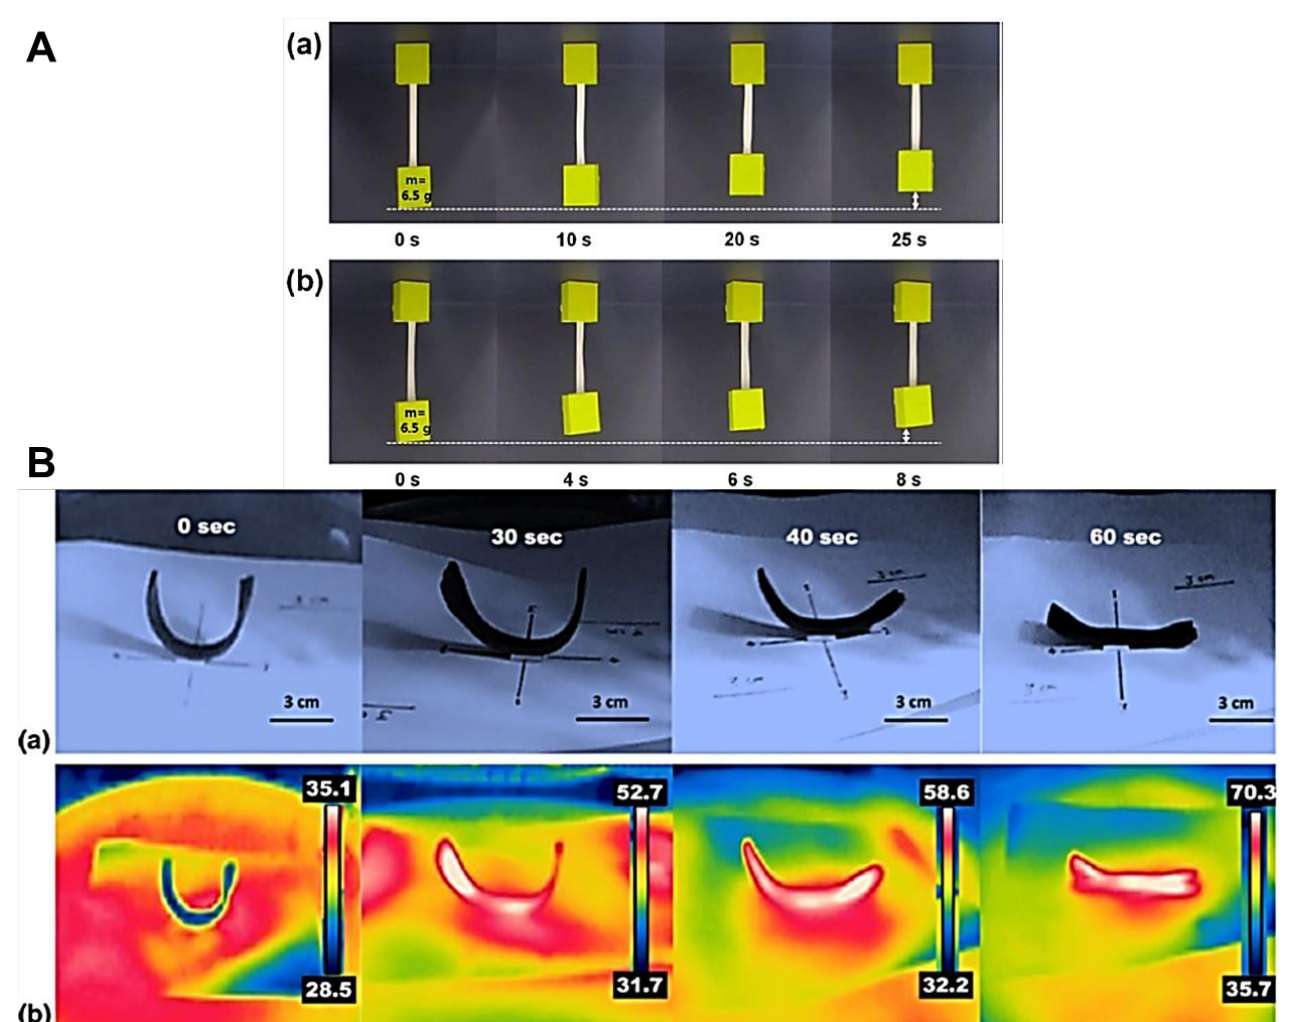
Figure 6. ( A ) Shape recovery images of ( a ) PU and ( b ) PU/GO nanocomposite, where shape recovery test was carried out at a constant temperature of 50 °C with increasing time [113]. PU = polyurethane; PU/GO = polyurethane/graphene oxide. Reproduced with permission from ACS. ( B ) Sequence of shape recovery of shape memory polyurethane/graphene nanoplatelets under microwave irradiation: ( a ) digital images; ( b ) infrared thermal images [114]. Reproduced with permission from Springer.